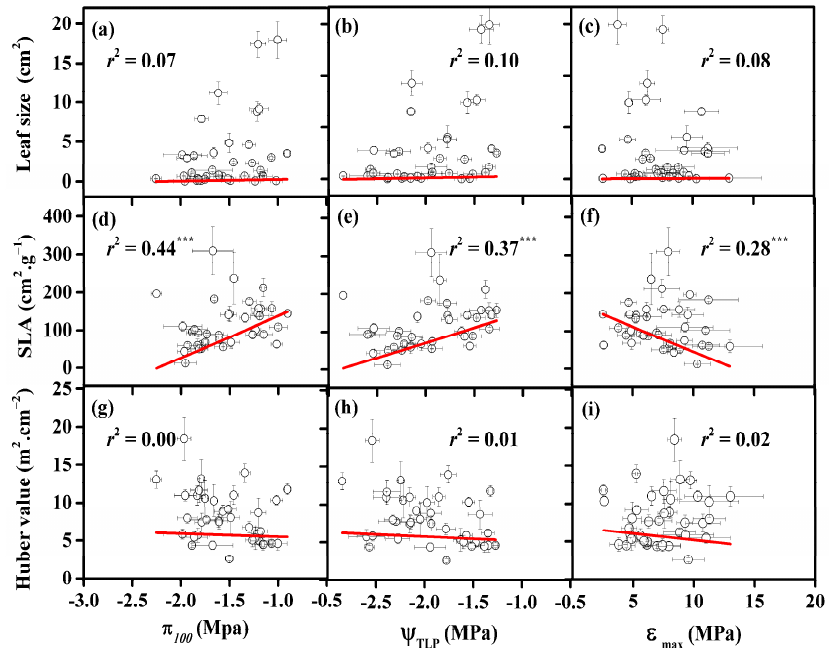
Figure 5. Correlations between each of three traits, osmotic potential at full turgor ( π 100 ), turgor loss point ( Ψ TLP ) and modulus of elasticity ( ε max ), and leaf size, specific leaf area (SLA) and Huber value. Solid lines represent the linear regressions, and the associated r 2 values are provided (* P < 0.05, ** P < 0.01, *** P < 0.001). Data are means ± 1 SE.